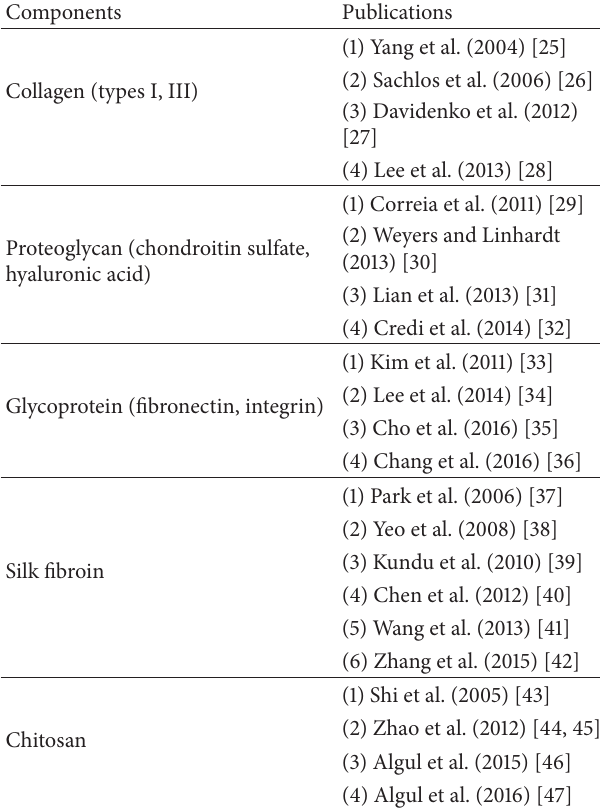
Table 3: ECM components and biomimetic